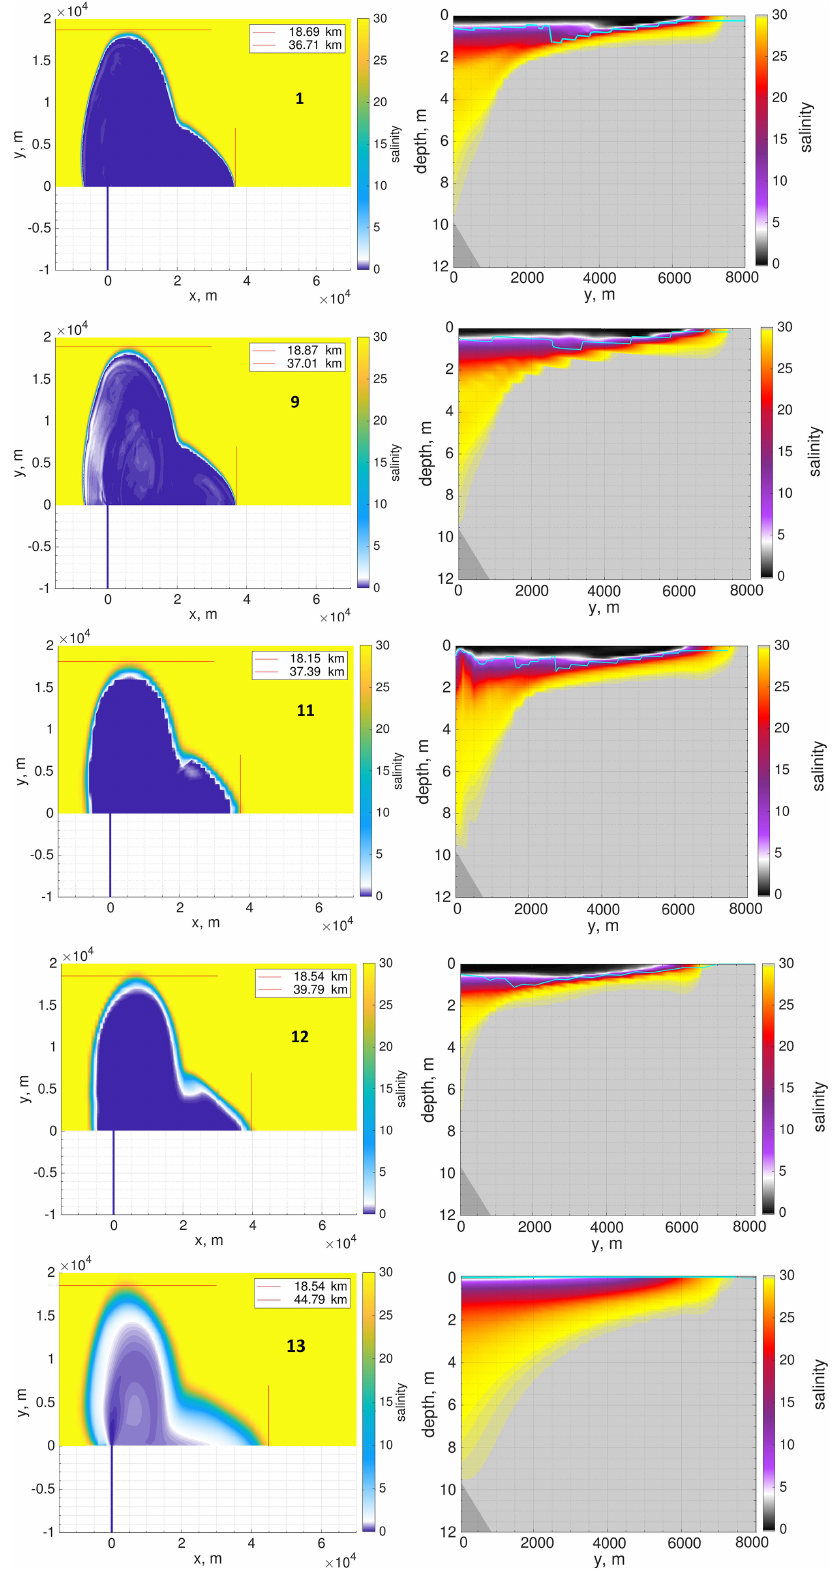
Figure A2. Salinity, in practical scale, as a result of the different runs at 35h at the surface (left panels) and coastal current transect (right panels) (see Table A1 for the run